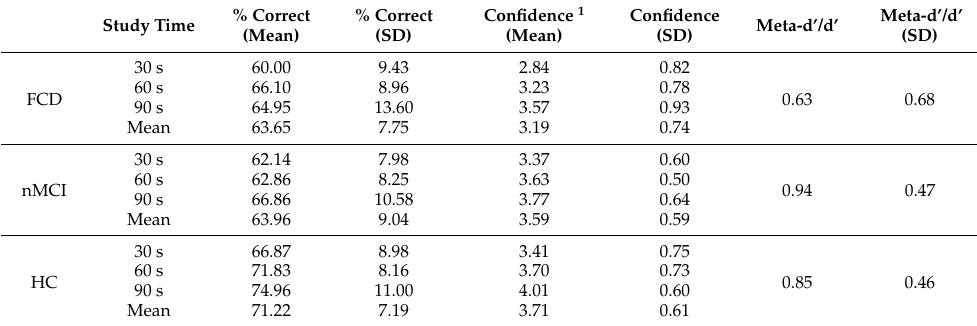
Table 2. Memory Task Performance and